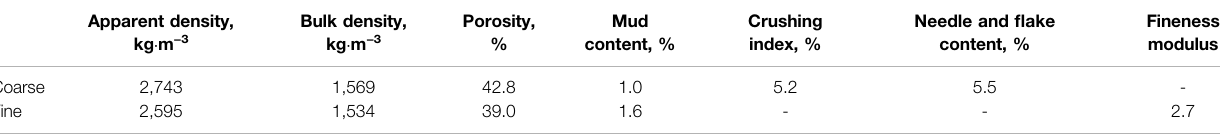
TABLE 4 | Technical indexes of coarse and aggregate.